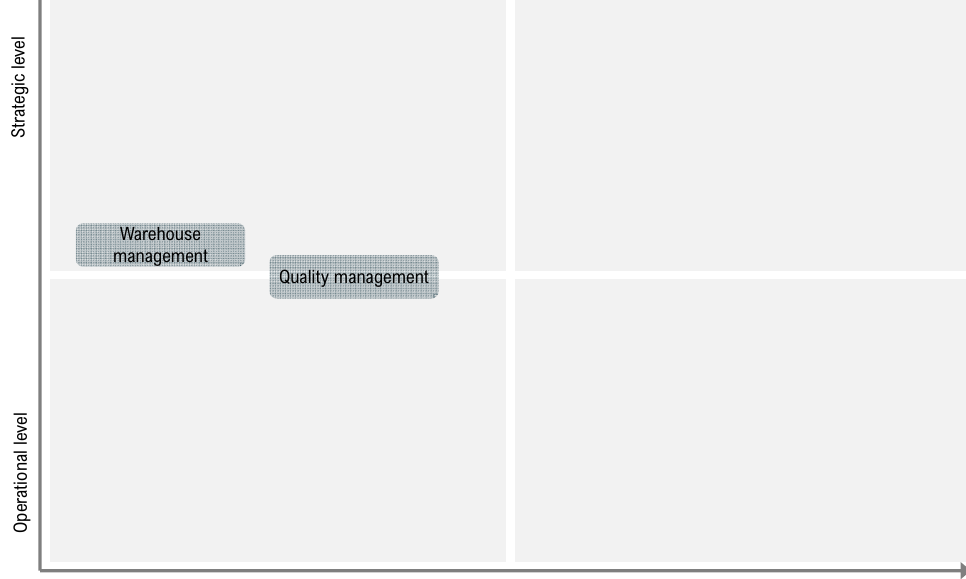
Figure 17. Suggested fields of action for the advanced profile.